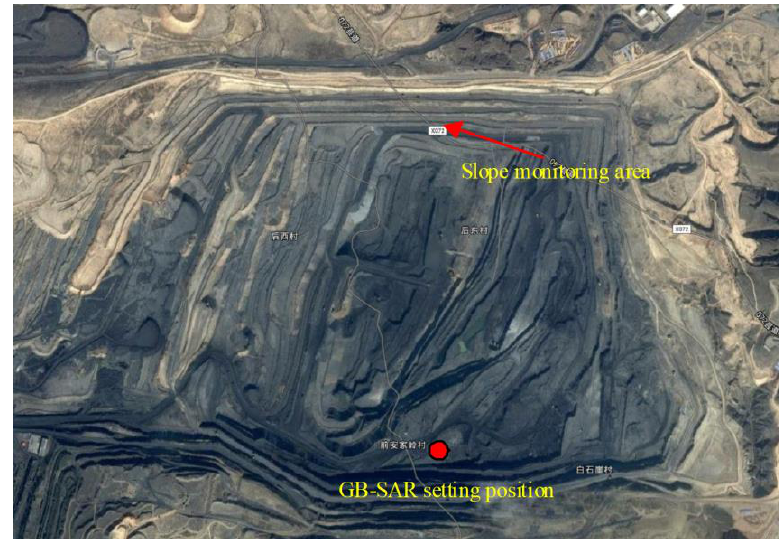
Figure 7. Ground-based interferometric radar (GB-SAR) setting position and the monitored slope.